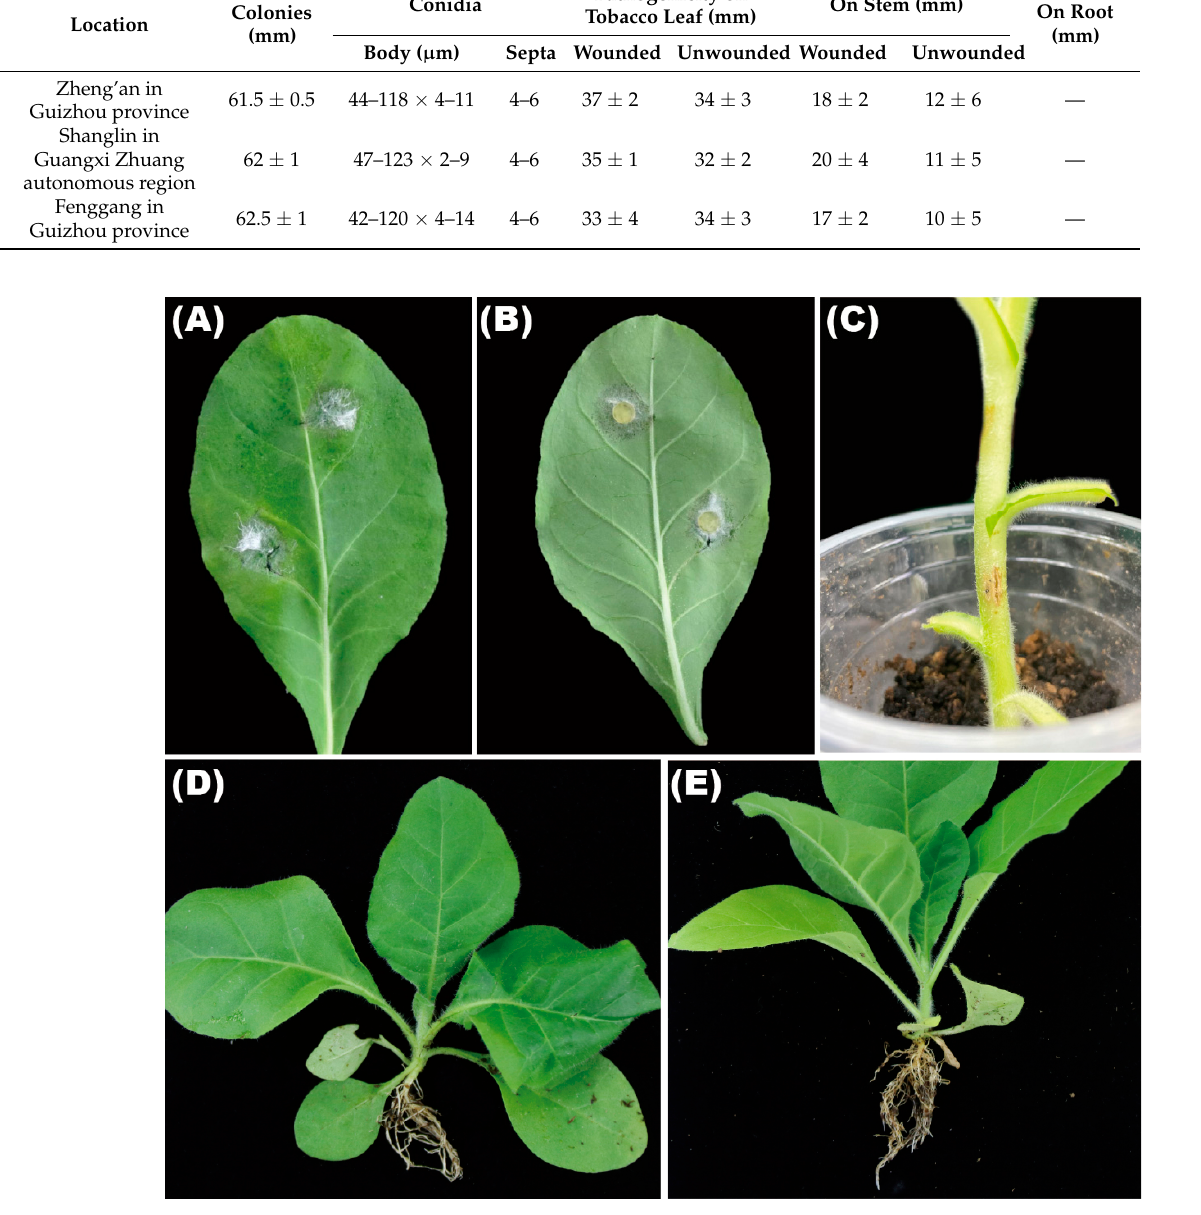
Figure 4. Pathogenicity on tobacco ( A , B ) leaves, ( C ) stems, and ( D ) roots. ( E ) The roots of control plant. Table 2. Morphology characterization and pathogenicity of F . ipomoeae.